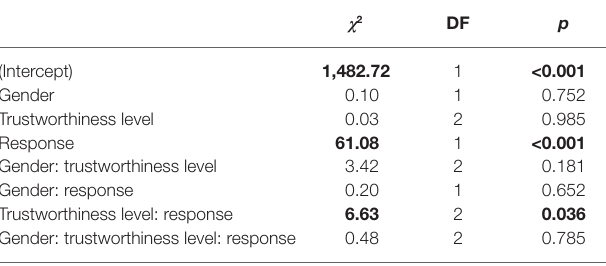
TABLE 4 | Omnibus test of effects for gender, trustworthiness and given response on RTs.